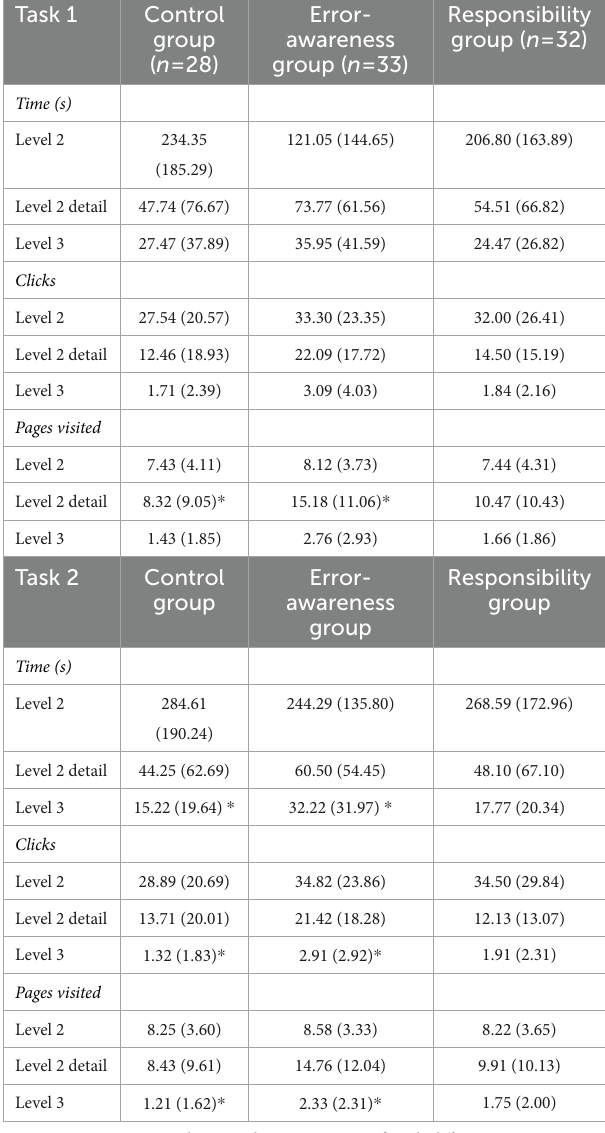
TABLE 4 Means and standard deviations of verification intensity indicators for each instruction group.